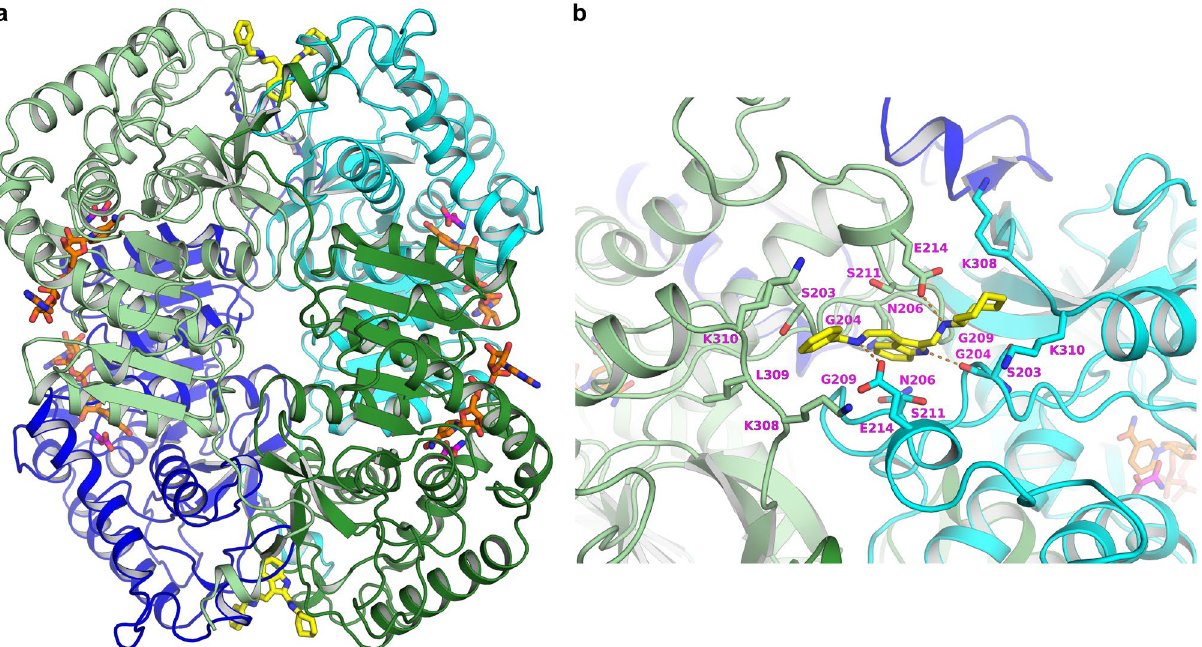
Figure 5. Crystal structure of the quaternary LDHB/NADH/oxamate/AXKO-0046 complex. ( a) Ribbon diagram. ( b) Close-up view of the binding site of AXKO-0046. Each monomer of the tetramers is shown in